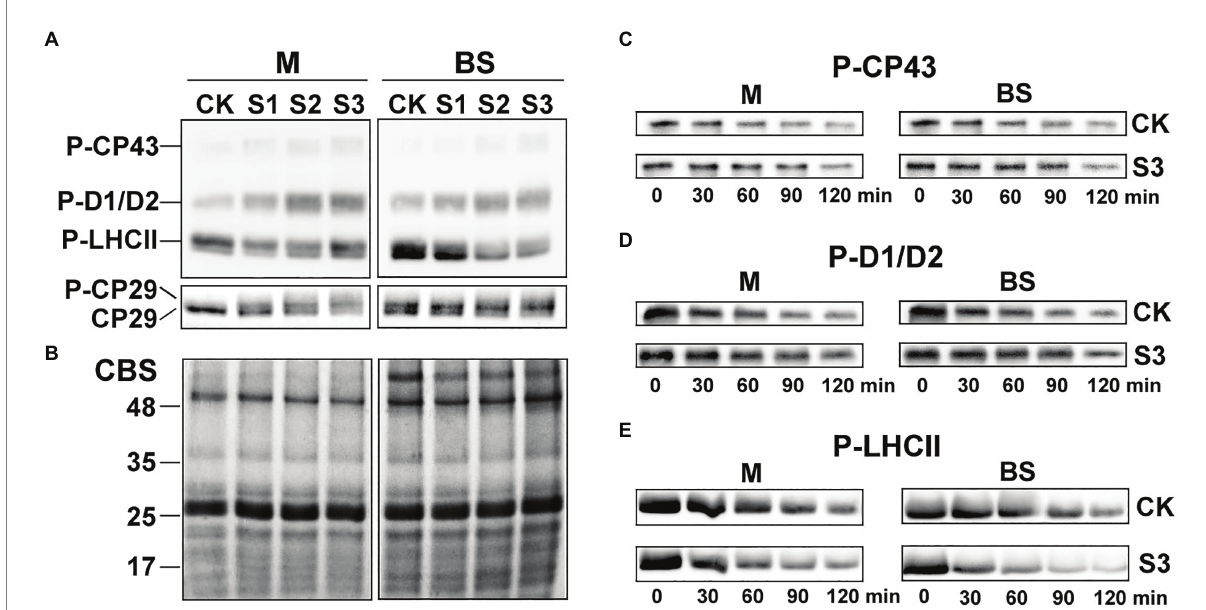
FIGURE 5 Reversible phosphorylation of PSII proteins in M and BS chloroplasts of maize leaves under drought stress. (A) Immunoblot analysis of the PSII proteins phosphorylation in M and BS chloroplasts under drought stress. Proteins in M (1.0 μ g Chl) and BS chloroplasts (1.5 μ g Chl), were detected with anti-PThr antibody. (B) Coomassie staining of protein samples (CBS) was shown as a control. The positions of detected phosphoproteins and molecular masses of protein markers (in kDa) are indicated. (C–E) Dephosphorylation of PSII proteins in vivo under severe drought stress. Maize leaves were illuminated 120 min at 25 ° C and then transferred to darkness and incubated at 25 ° C. Dephosphorylation was terminated at the indicated time points by freezing the leaves in liquid nitrogen. Thylakoid membranes in M and BS cells were isolated and the extent of protein phosphorylation was determined using anti-PThr antibody. Before conducting the dephosphorylation experiments, different light intensities were used for induction of higher in vivo phosphorylation levels of either core proteins or LHCII. Maize leaves were illuminated under a PFD 1,000 μ mol photons m − 2 s − 1 for more effective phosphorylation of PSII core proteins (C,D) or under a PFD 80 μ mol photons m − 2 s − 1 for induction of LHCII phosphorylation (E) . CK, well-watered control; S1, mild drought stress; S2, moderate drought stress; and S3, severe drought stress. The results shown are representative of those obtained in at least three independent experiments. Thylakoids were isolated in the presence of 10 mM